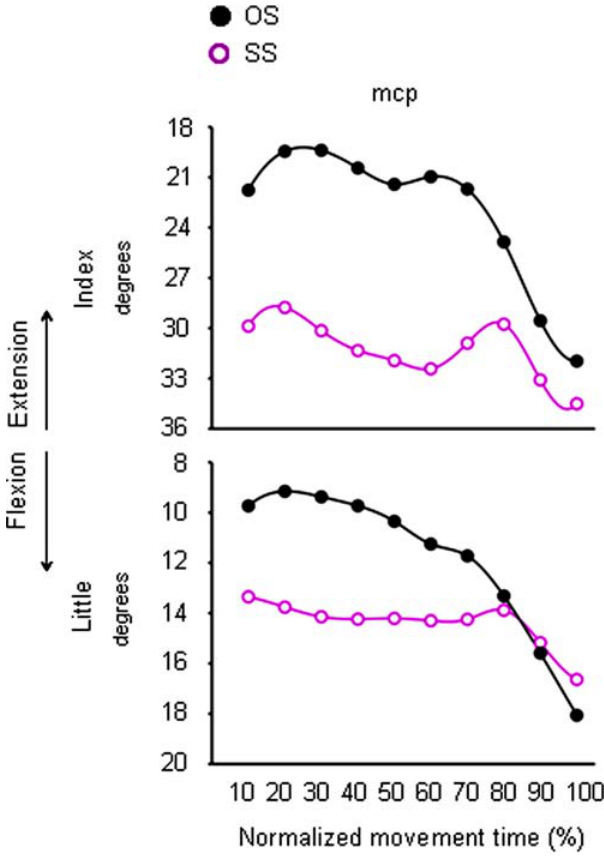
Figure 8. Time course of finger motion during reaching for the small target either in the absence or in the presence of an odour evoking a small object. Each trace denotes average angular excursion of a representative subject (Subject 2) for the mcp joint of the index and the little fingers when performing the ‘OS’ (black circles) and the ‘SS’ (purple circles) conditions. Positive values correspond to finger flexion whereas negative values correspond to finger extension. OS=Odourless air-Small target; SS=‘Small’ odour-Small target. doi:10.1371/journal.pone.0001795.g008 PLoS ONE |